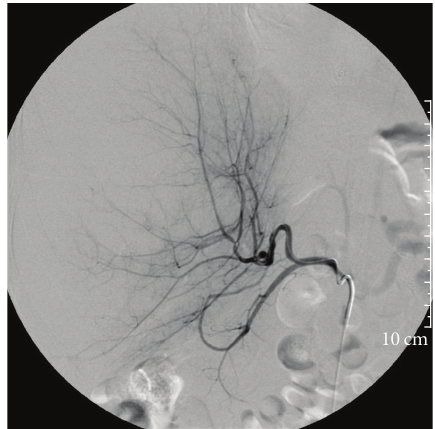
Figure 2: Hepatic arteriogram demonstrating medial displacement of hepatic arterioles due to mass e ff ect of hematoma and lack of any arterial bleeding